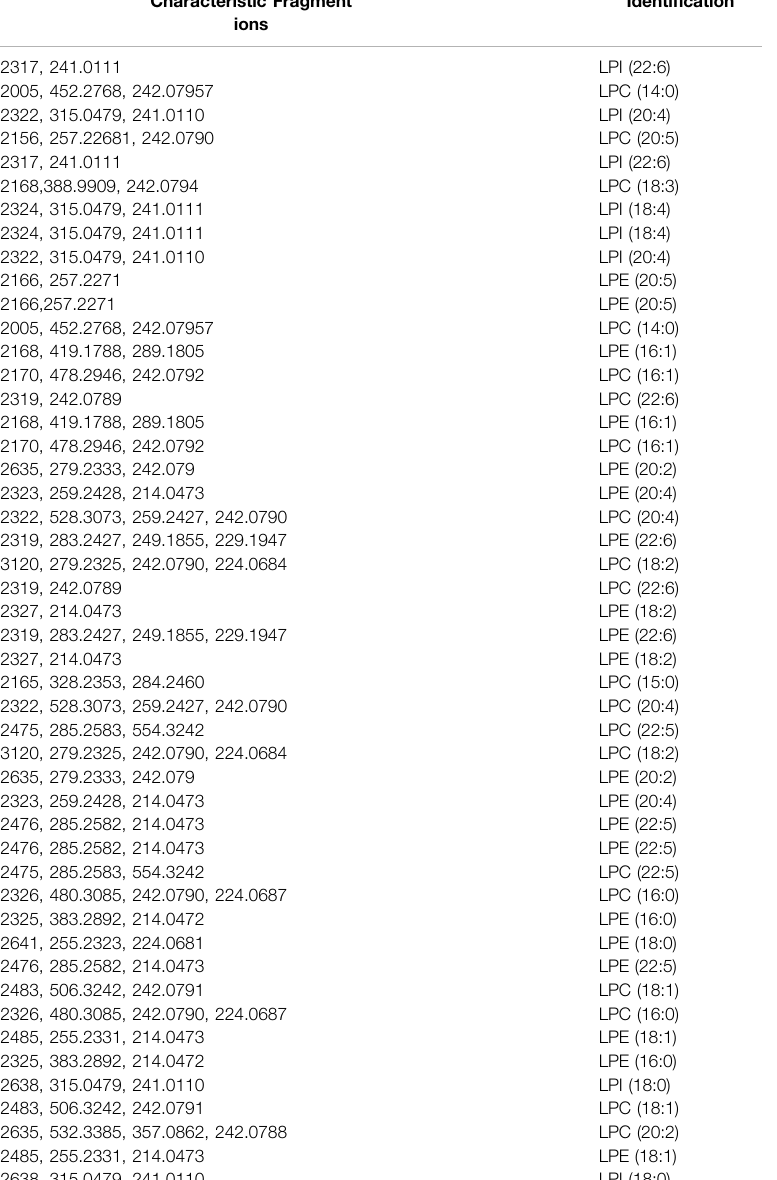
Molecular formula Characteristic Fragment (ppm)